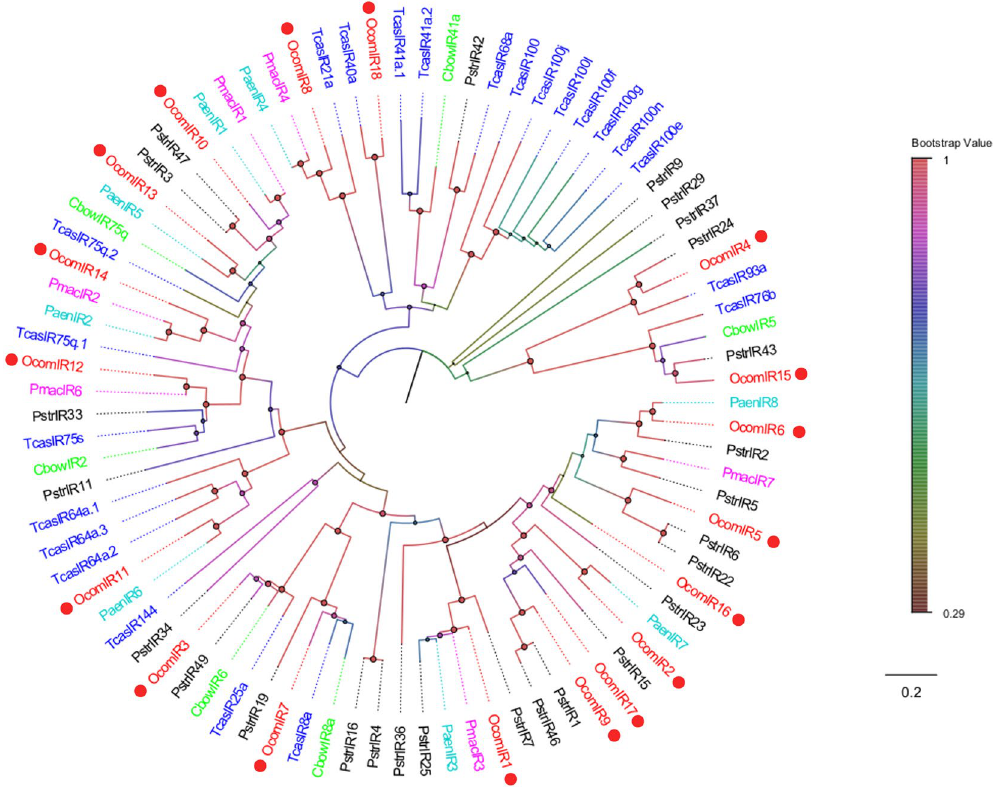
Figure 8. Neighbor joining phylogenetic tree of candidate OcomIRs with known Coleopteran IR sequences. Tcas, Tribolium castaneum (N = 23); Pmac, Pyrrhalta maculicollis (N = 6); Paen, Pyrrhalta aenescens (N = 8); Pstr, Phyllotreta striolata (N = 26); Cbow, Colaphellus bowringi (N = 6). Candidate OcomIRs were indicated by red